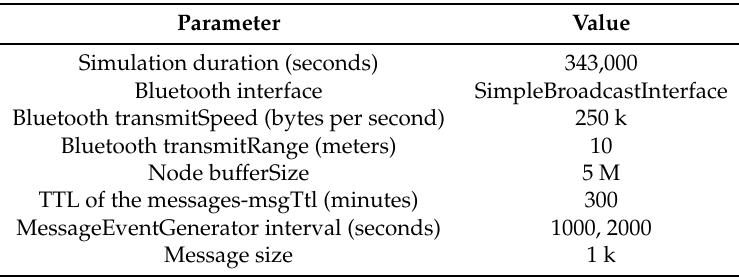
Table 2. Simulation